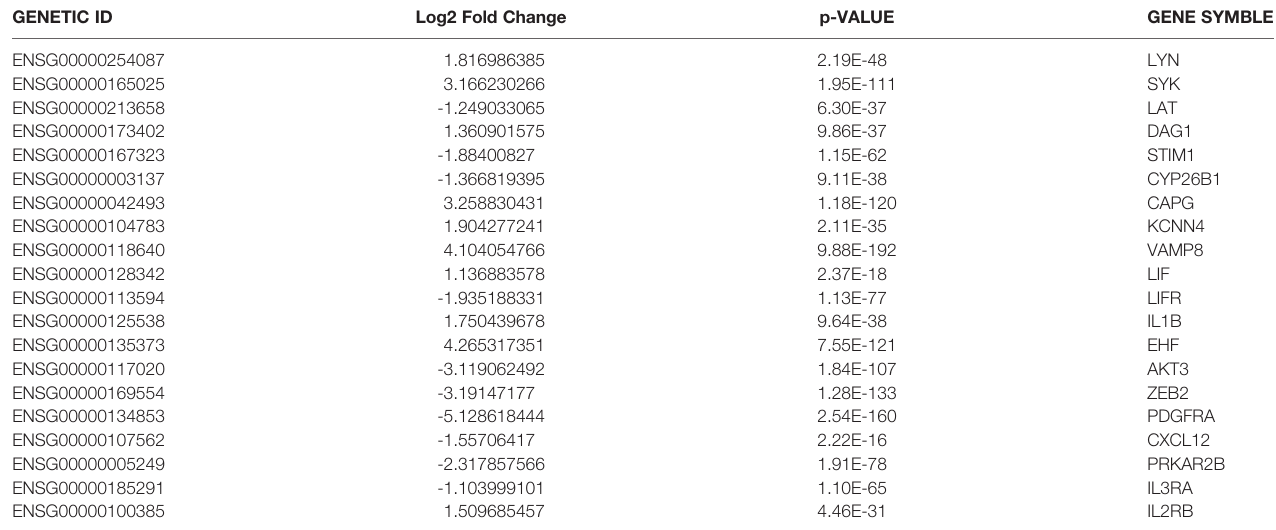
TABLE 1 | Differentially Expressed Genes Associated with Mast Cell. GENETIC